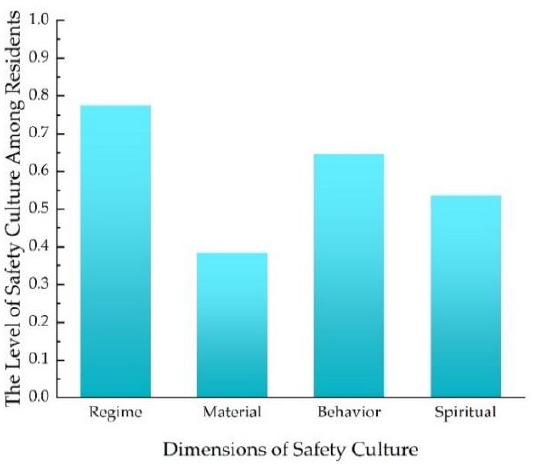
Figure 8. The levels of the four dimensions of culture among residents.